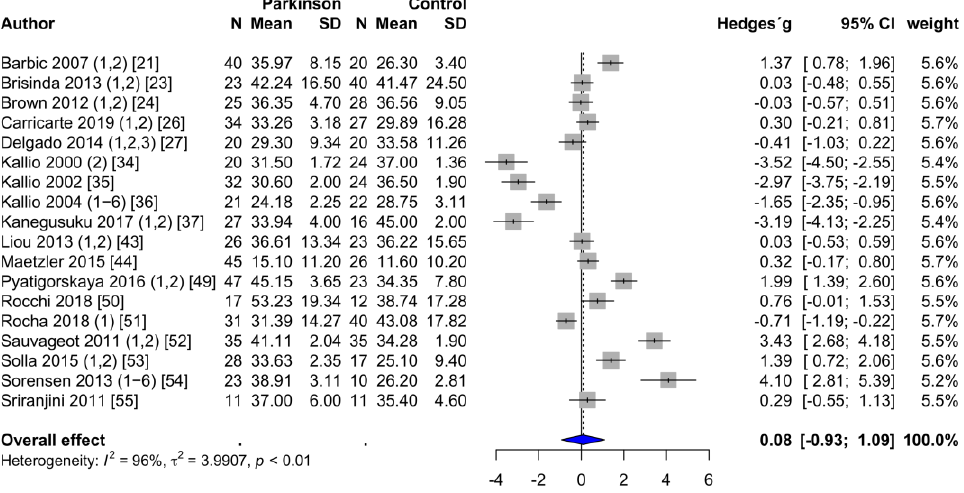
Figure 4. Forest plot RMSSD, random-effects meta-analysis. RMSSD: Root mean square of succes- sive normal-to-normal interval differences. pNN50 . The pNN50 was reported in 14 studies [19,23,27,28,34,40,41,44,46,52–55,57]. The mean pNN50 was 4.7 ± 1.1% in PD patients and 6.8 ± 1.3% in the healthy control group. These differences are statistically not significant ( p = 0.378). According to Egger’s test, there was evidence of publication bias ( p = 0.043). Adding the four missing studies that the trim-and-fill procedure identified, the adjusted estimate of the effect size did not